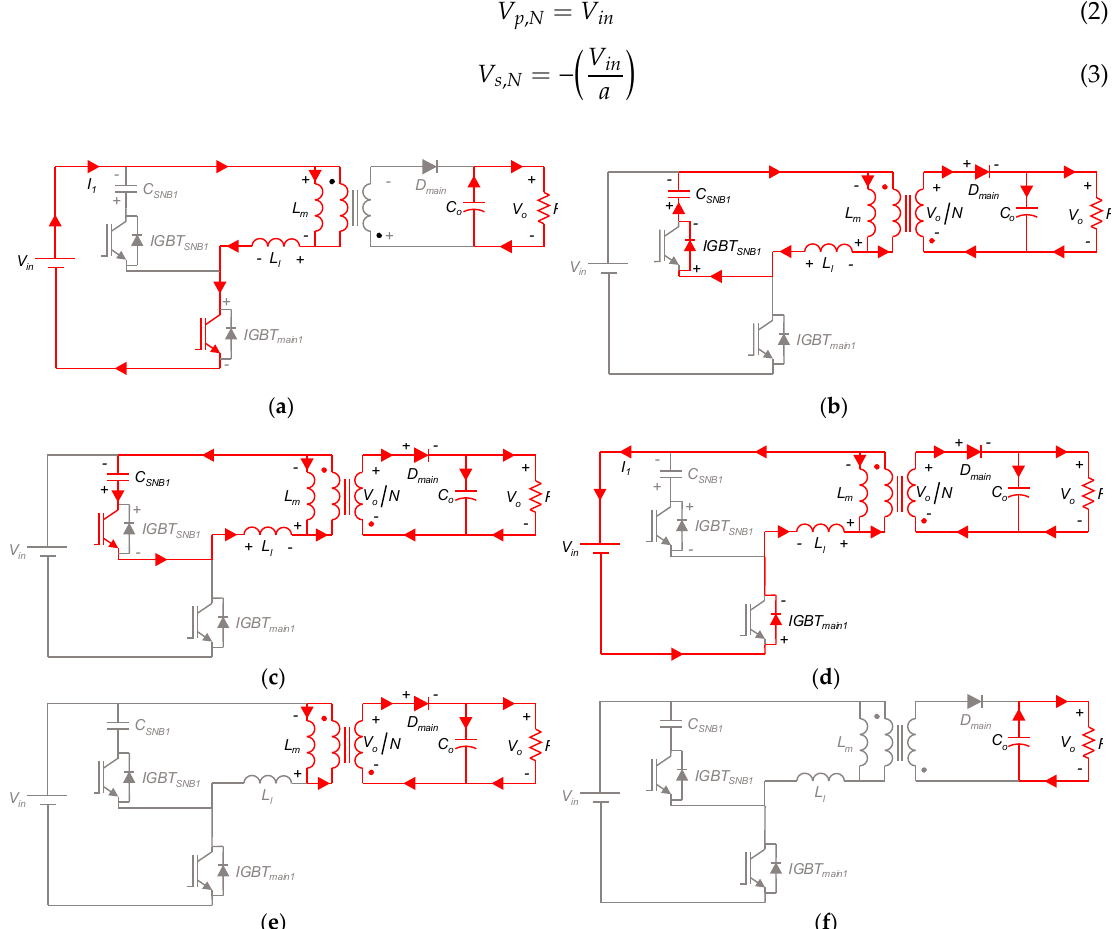
Figure 3. Equivalent circuits for each operating mode: ( a ) Mode 1; ( b ) Mode 2; ( c ) Mode 3; ( d ) Mode 4; ( e ) Mode 5; ( f ) Mode 6.